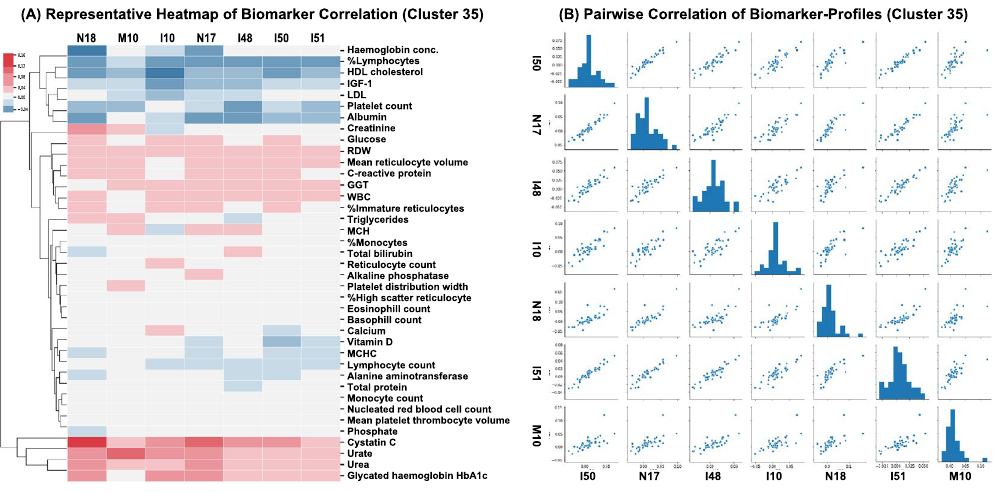
Figure 5. Example of a disease cluster (Cluster 35) formed by UMAP-DBSCAN Algorithm. ( A ) Heatmap of mean weighted hazard ratios. The cluster consists of seven diseases—N18 Chronic renal failure, M10 Gout, I10 Essential (primary) hypertension, N17 Acute renal failure, I48 Atrial fibrillation and flutter, I50 Heart failure, I51 Complications and Ill-defined descriptions of heart disease. Diseases in this cluster share a common profile of biomarkers associated with reduced risk (Albumin, HDL, Hemoglobin Conc), and increased risk with diabetes (HgA1c) and kidney function (CystatinC, Urea). ( B ) Correlation of risk profiles for all pairs of diseases in a cluster. The pairwise plots show a strong correlation between hazard